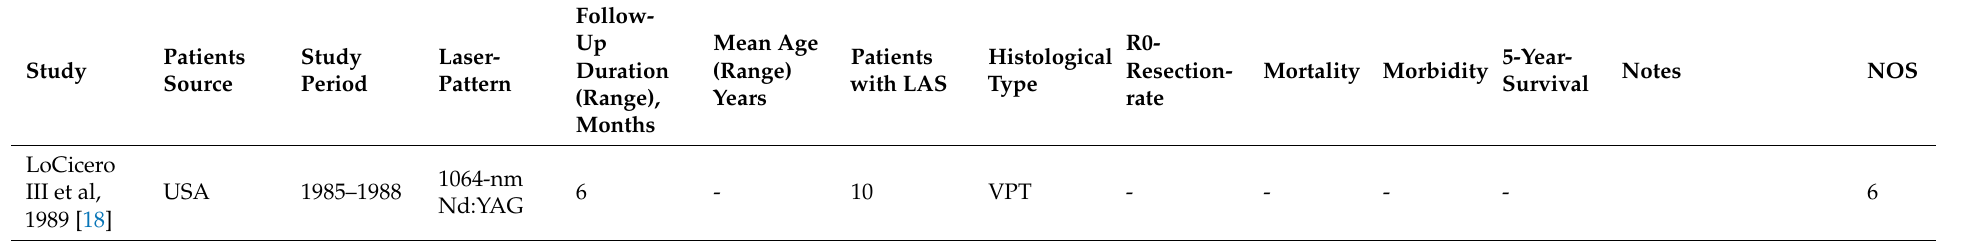
Table 1. Basic characteristics of the included